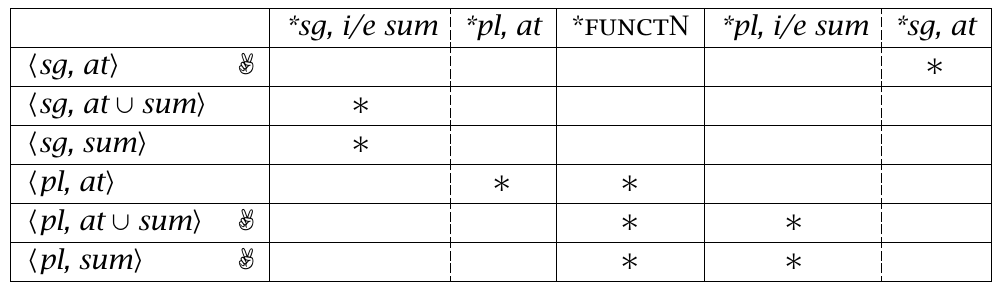
Tableau 1 Optimization over singular/plural form-meaning pairs Tableau 1 , where singular and plural forms are paired up with their